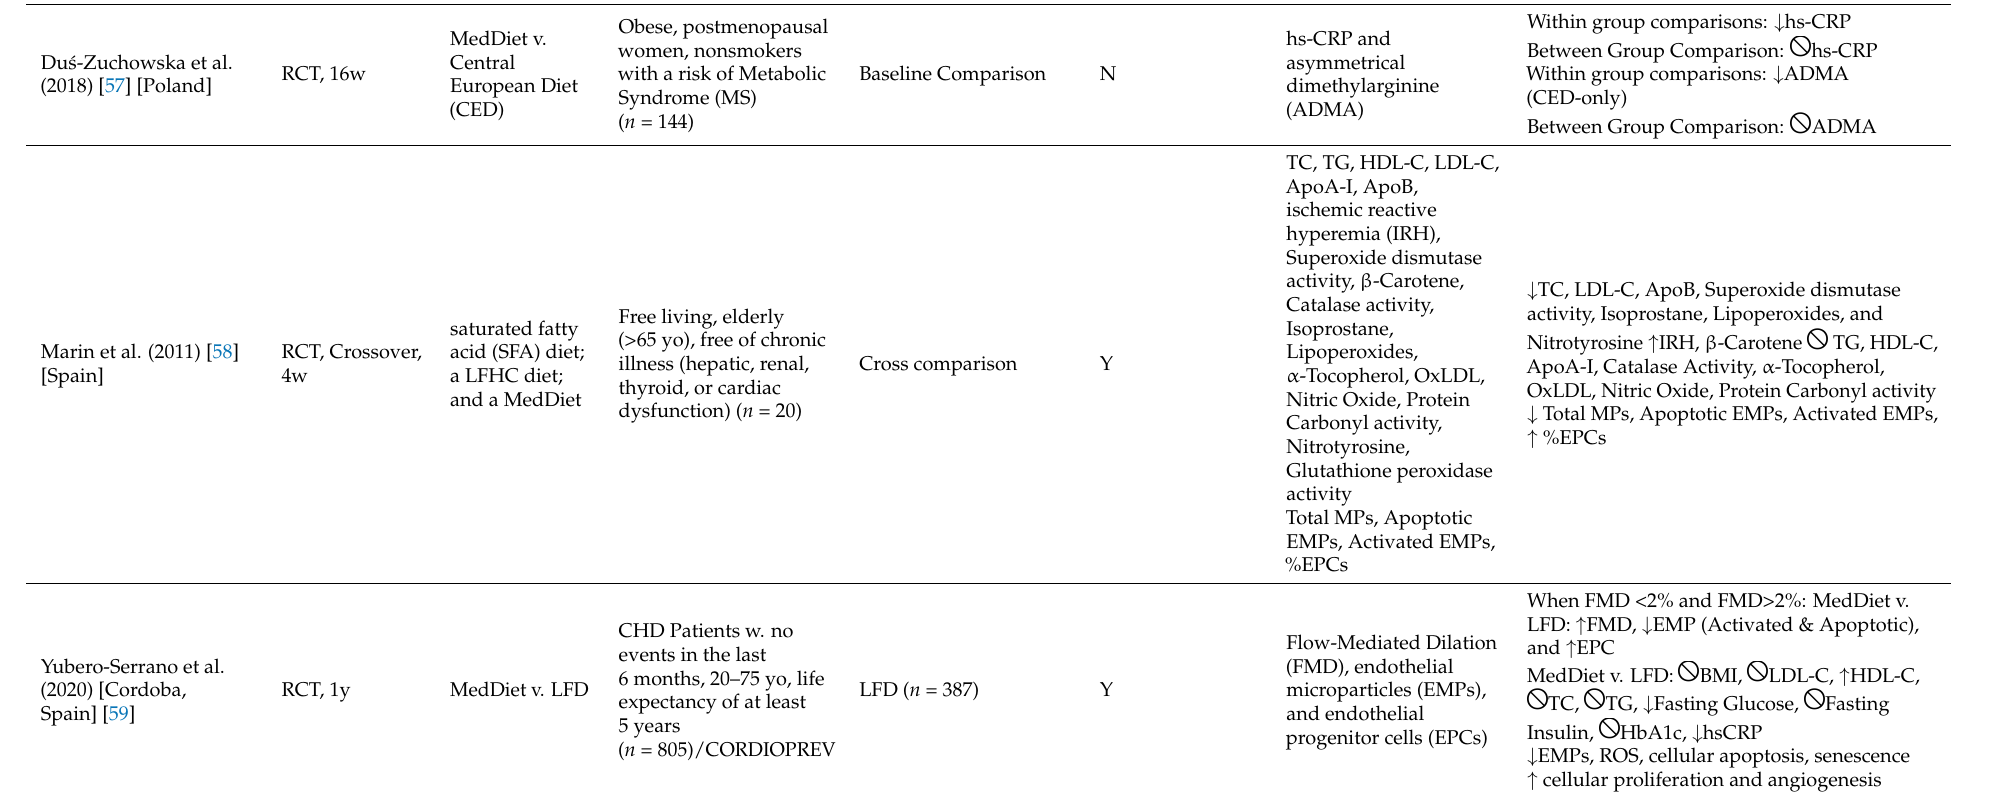
Table 2. Clinical Studies.